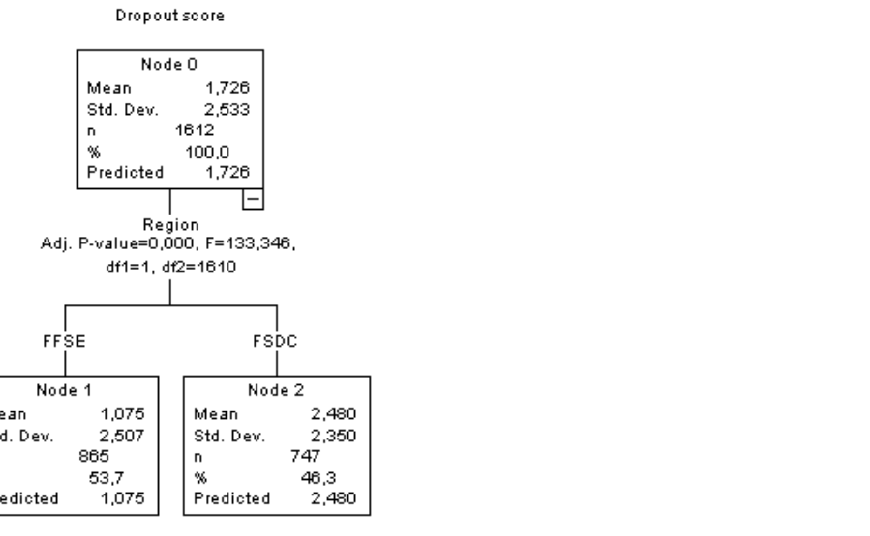
Figure 4. CHAID analysis with dropout score as dependent variable (without Academic Cohorts).